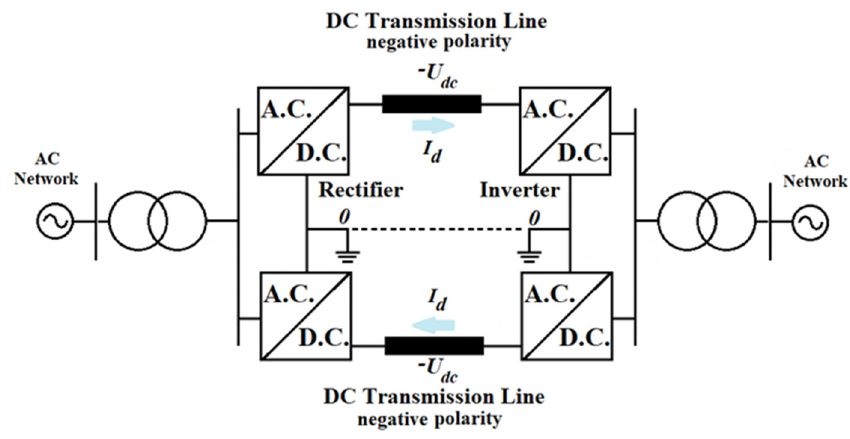
Figure 7. HVDC homopolar link.